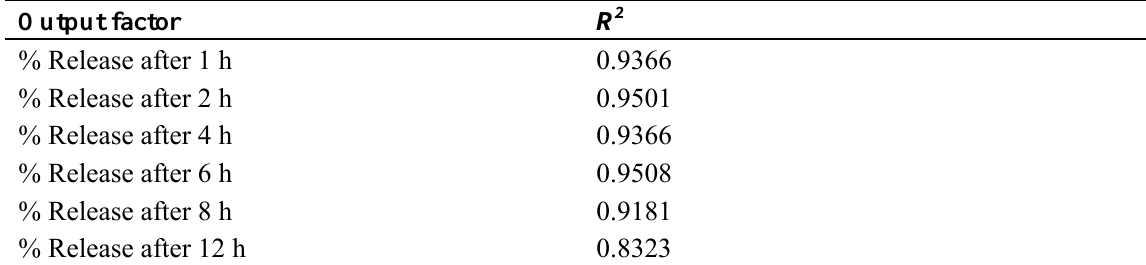
Table 2. Correlation of output factors.